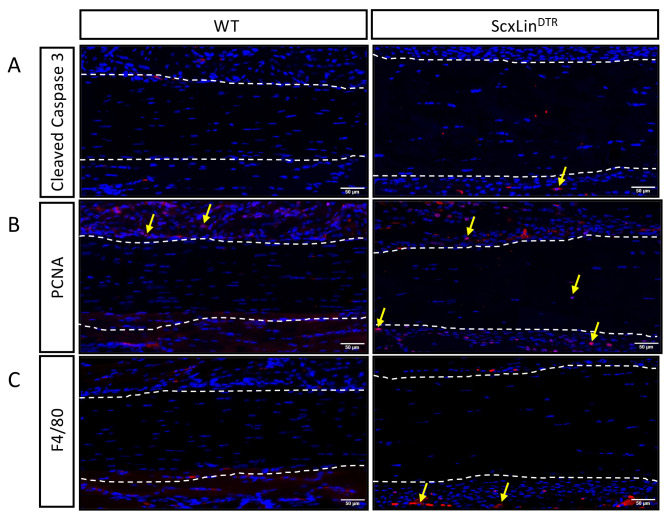
ScxLinDTR does not cause substantial effects on surrounding tissue.Assessment of apoptosis (Cleaved Caspase 3, A), proliferation (PCNA, B), and Inflammation (F4/80, macrophages, C) for WT and ScxLinDTR uninjured tendons. Tendon outlined by white dotted line. Nuclei stained with DAPI. Examples of positive stain indicated by yellow arrows. N = 3 per genotype.